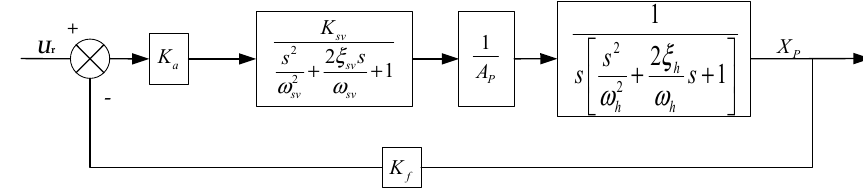
Figure 2. Structure block diagram of an electro-hydraulic position servo